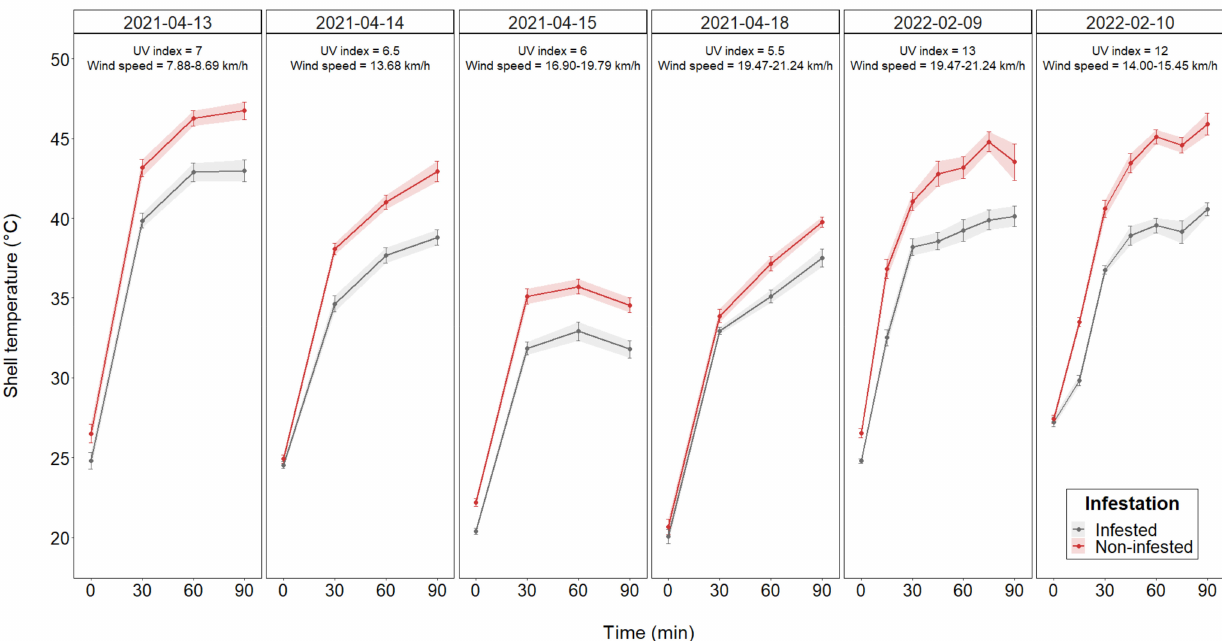
Figure 1. Changes in mean ( ± SE) shell temperatures (in ◦ C) of infested and non-infested indi- vidual biomimetic mussels ( Perna perna ) for 90 min after emersion ( n = 3 mussel beds) on each experimental date.